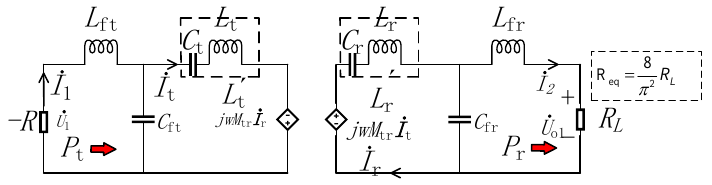
Figure 9. Conventional PT-WPT equivalent circuit.